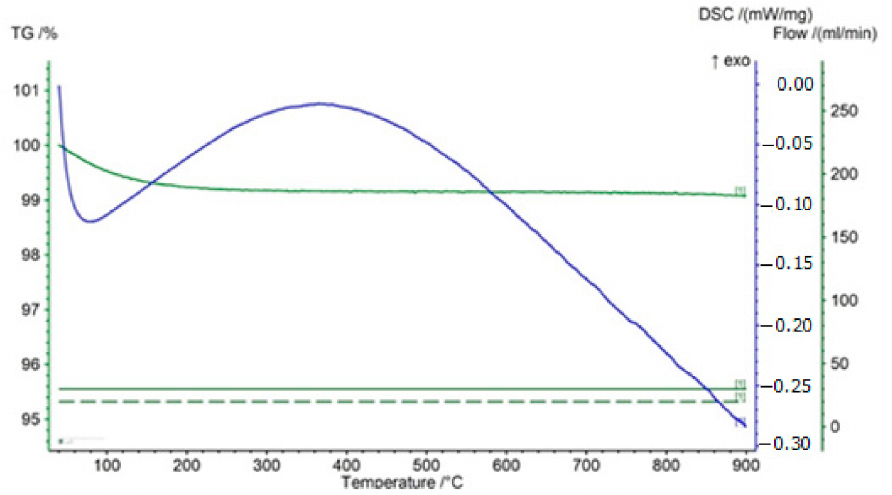
Figure 3. TG and DSC analysis of carbon foam